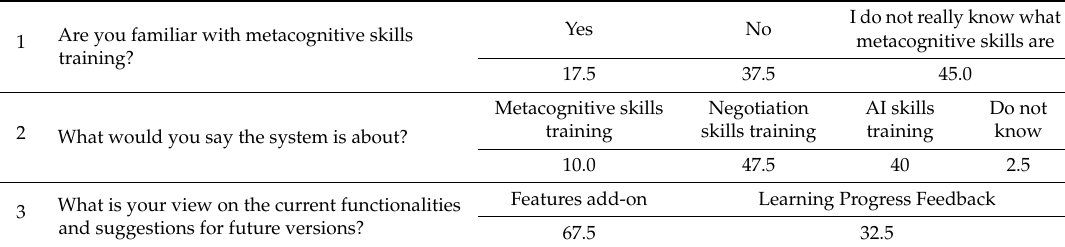
Table 5. Distribution (%) of user perceptions regarding metacognitive training, system scope and suggestions for future improvement (N =